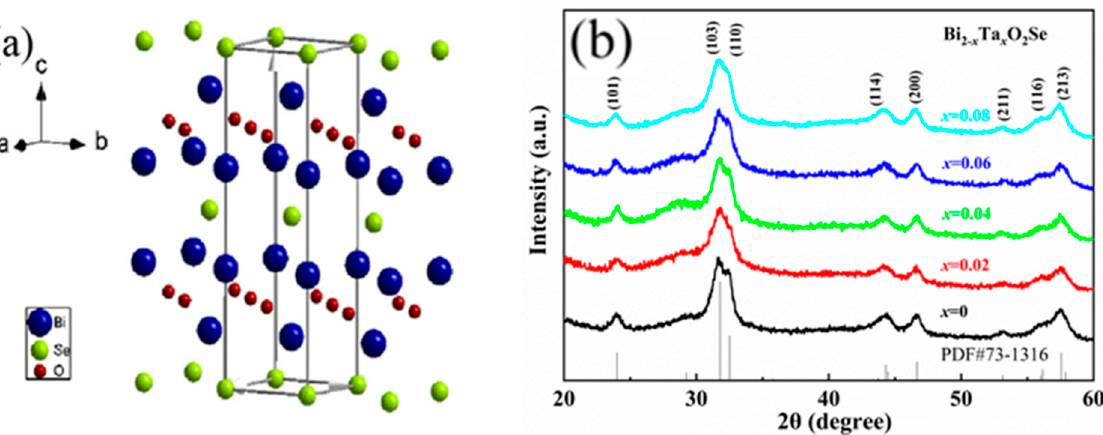
Figure 1. ( a ) Crystal structure of Bi 2 O 2 Se [32]. ( b ) XRD patterns of Bi 2 − x Ta x O 2 Se (x = 0, 0.02, 0.04, 0.06, and 0.08) ceramics.